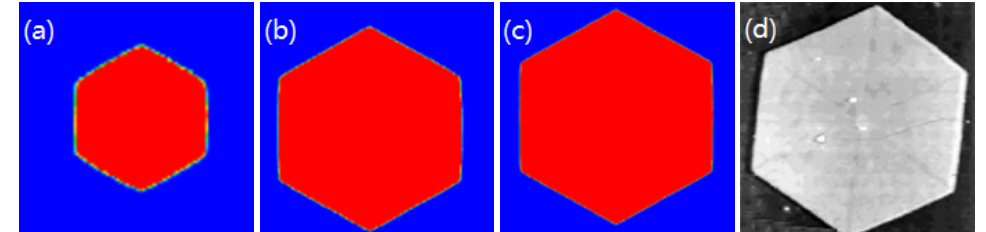
Figure 6. When K 0 = 0.8, the morphology of lamellar is obtained by numerical simulation. (( a – c ) are the numerical simulation results with time iteration steps of 1000, 3000 and 5000, respectively. ( d ) is the experimental